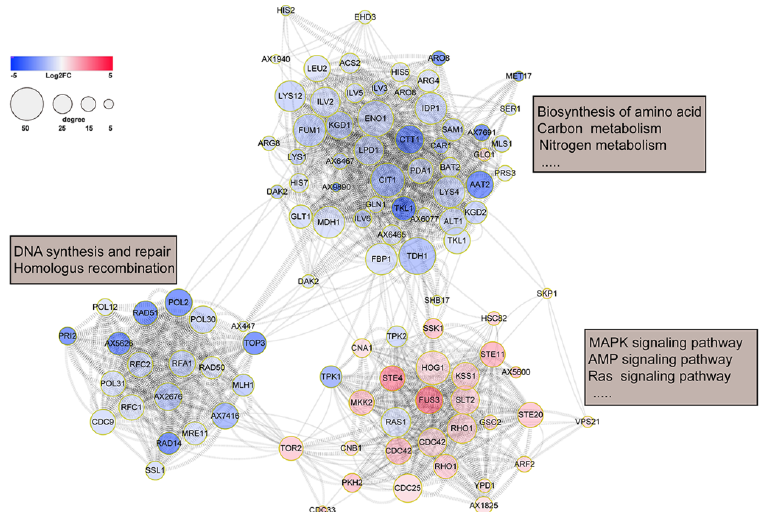
Figure 3. Visualization of significantly enriched KEGG pathways and predicted protein–protein interaction network of DEPs. The color scale of log2 (fold change) and the size scale of interaction edges are shown.